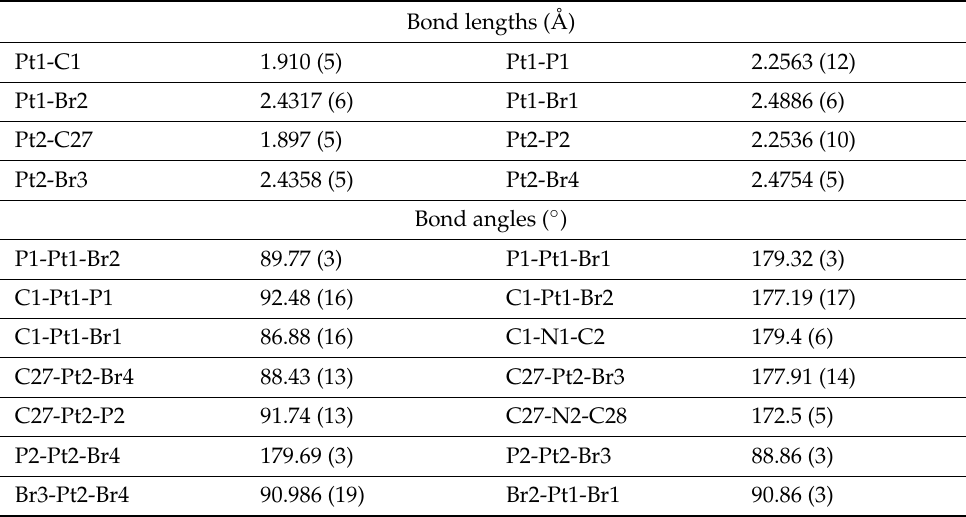
Figure 1. Structure of complex 3 . Dark gray: carbon; Light gray: hydrogen; Green: chlorine; Brown: Bromine; Yellow: phosphorus; White: platinum; Blue: nitrogen; Red: oxygen. Table 2. Most significant bond lengths and angles for complex 3 .